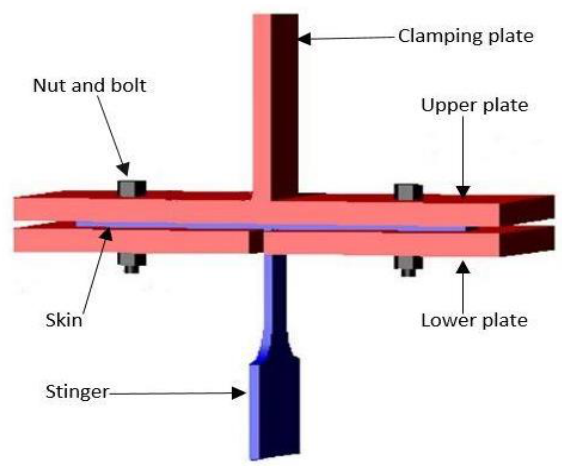
Figure 4. Tensile specimen and fixture for the tensile test.